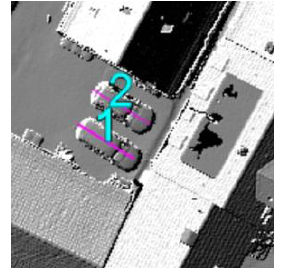
Figure 2. Example of two vehicles identified by crowdworkers